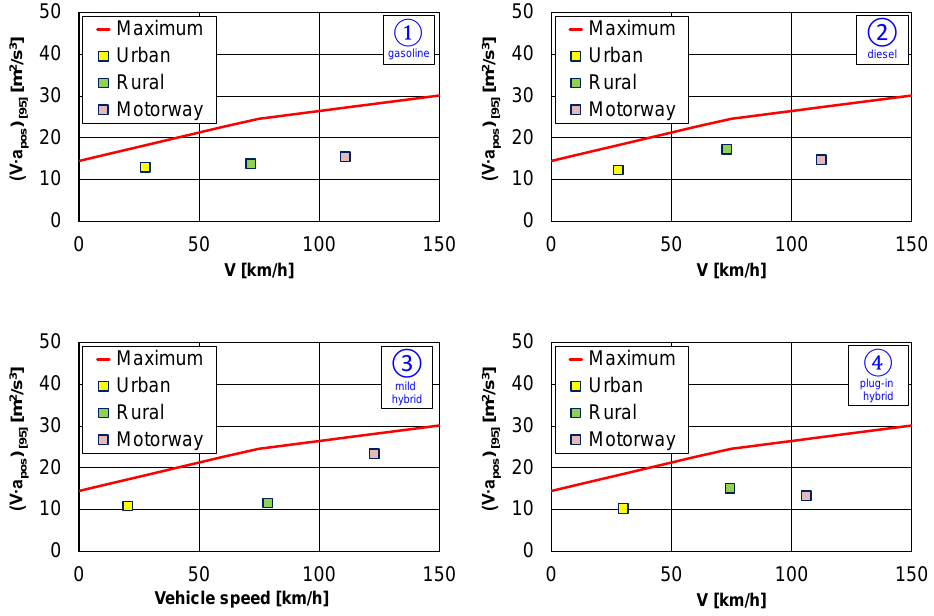
Figure 7. Values of driving dynamics parameters P95 of v ∙ a pos compared to the RDE limits for P95 of v ∙ a pos for vehicle 1 – 4; 1 — gasoline, 2 — diesel, 3 — mild hybrid, 4 — plug-in hybrid. For the vehicles tested, their driving dynamics were similar. None of them exceeded